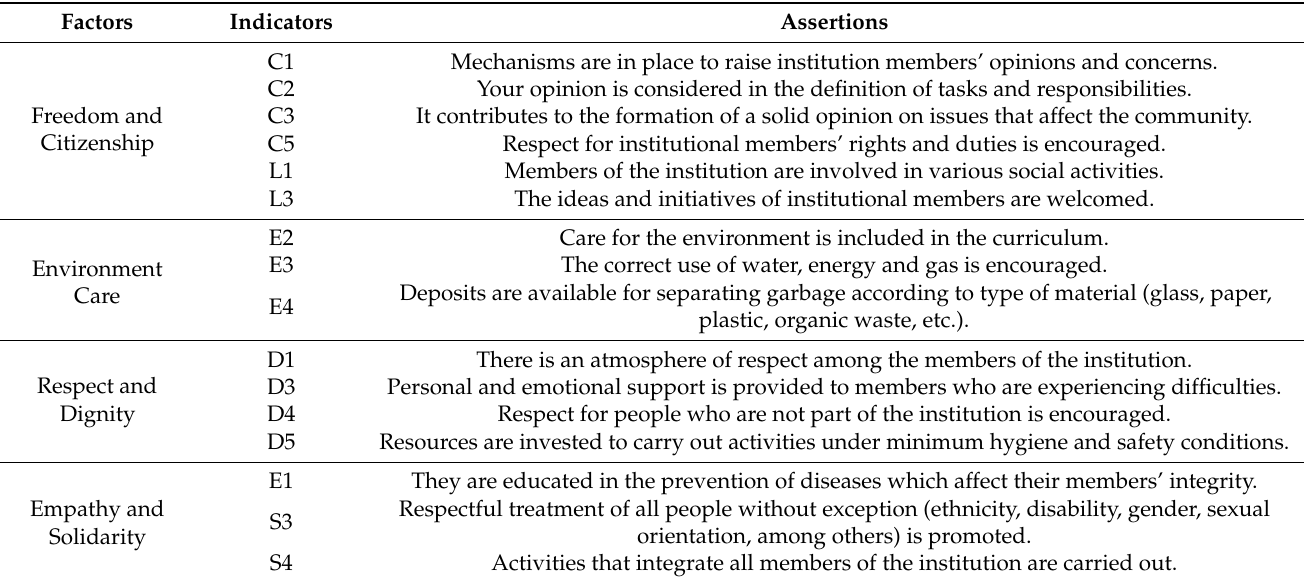
Table 6. Final indicators that make up the scale of social responsibility of HEIs from the perspective of SDGs according to the